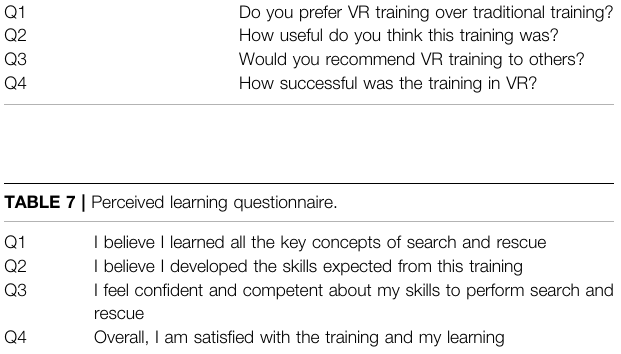
TABLE 8 | Results from the pre-experience questionnaire (All constructs have values from 0 (lowest) to 10